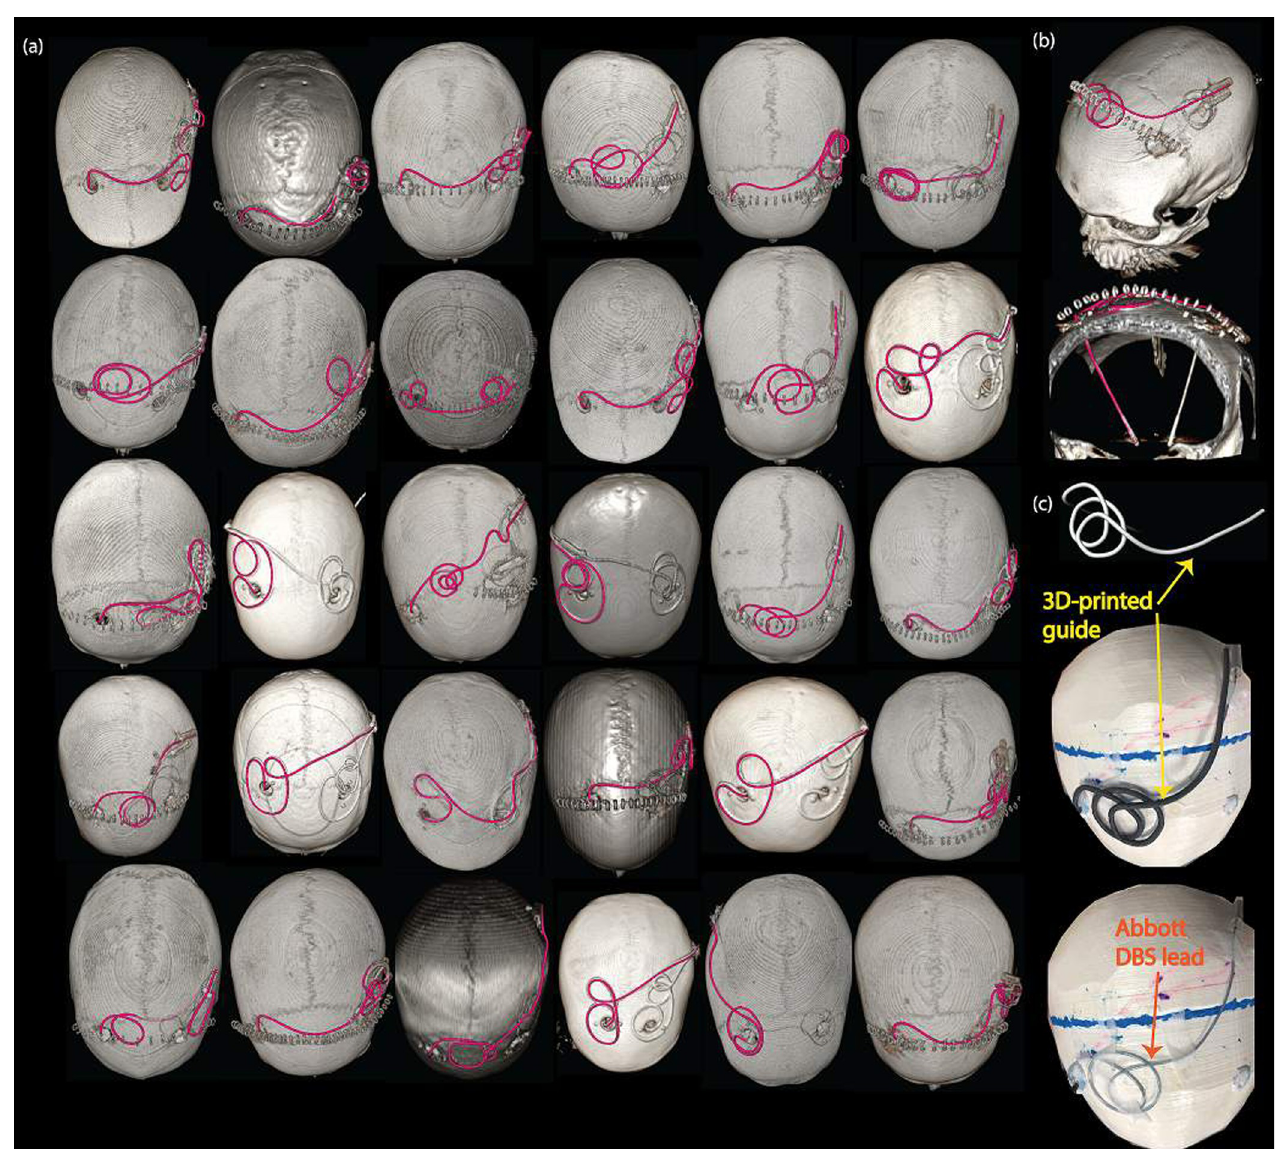
Fig 1. Evaluated DBS lead trajectories. (a) Thirty DBS lead trajectories were evaluated in this study. The trajectories are highlighted (magenta) on the 3D surface rendered views of computed tomography images of patients with implanted DBS leads. (b) Example segmentation of the DBS lead trajectory. (c) Example 3D printed model of a lead trajectory for replication in RF heating experiments with a commercial DBS